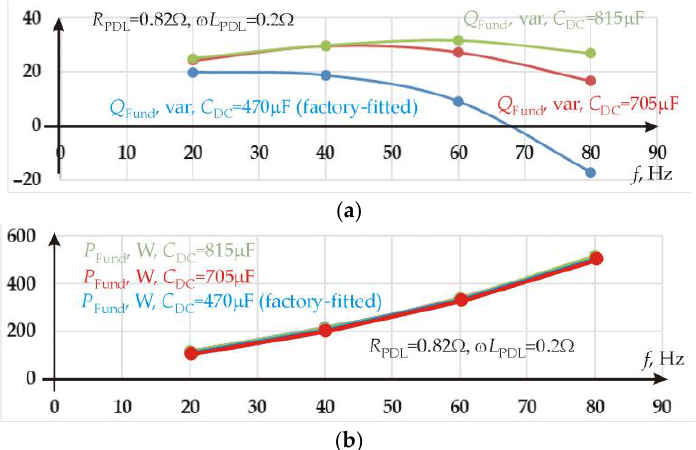
Figure 18. The power at the point of SIMOVERT P 6SE21 VFD connection to PDL at a function of induction motor frequency in case of different DC circuit capacitance value: ( a ) reactive power; ( b ) active power.